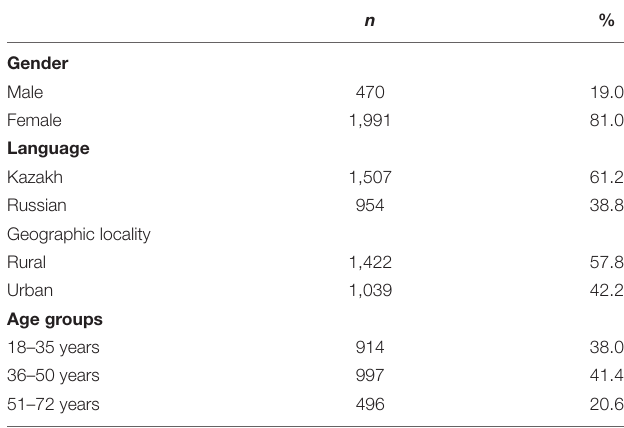
TABLE 1 | Distribution of raw sample responses in